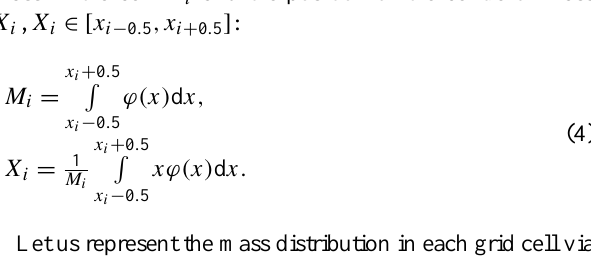
mass in the cell M i and the position of the centre of